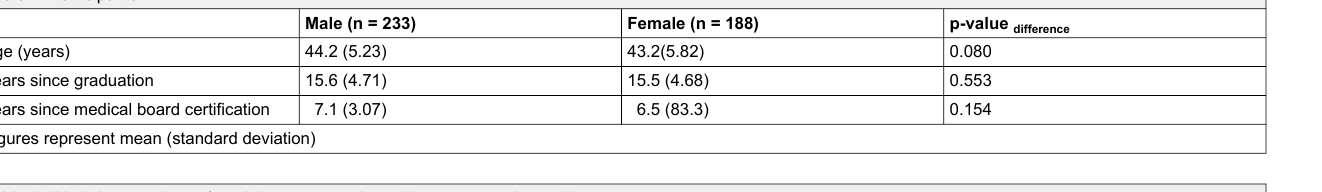
Table 1: Participants.